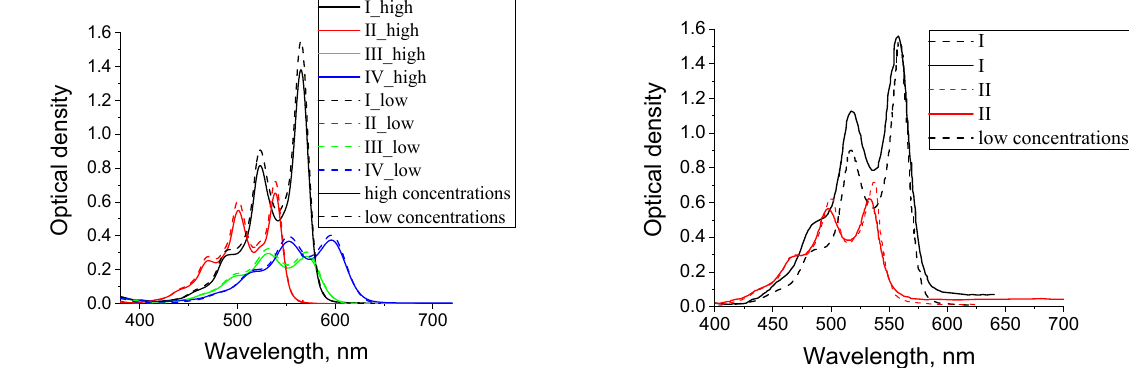
Figure 4. Dye absorption spectra I (C high =1.46 × 10 − 4 mol/L; C low =1.46 × 10 − 5 mol/L), II (C high =9.56 × 10 − 5 mol/L; C low =9.56 × 10 − 6 mol/L), III (C high =9.14 × 10 − 5 mol/L; C low =9.14 × 10 − 6 mol/L), IV (C high =8.58 × 10 − 5 mol/L; C low =8.58 × 10 − 6 mol/L) in toluene ( left ) and tetrahydrofuran ( right ). T = 293 K.